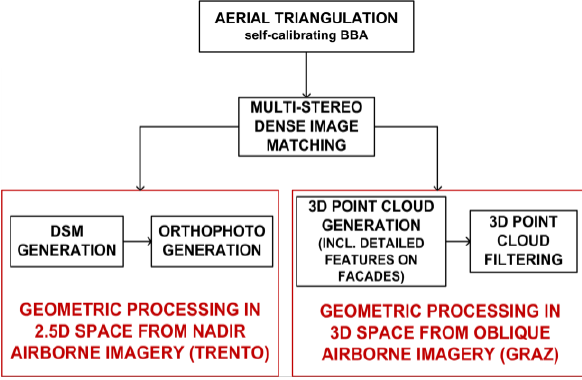
Figure 2. Adopted workflow for producing 3D